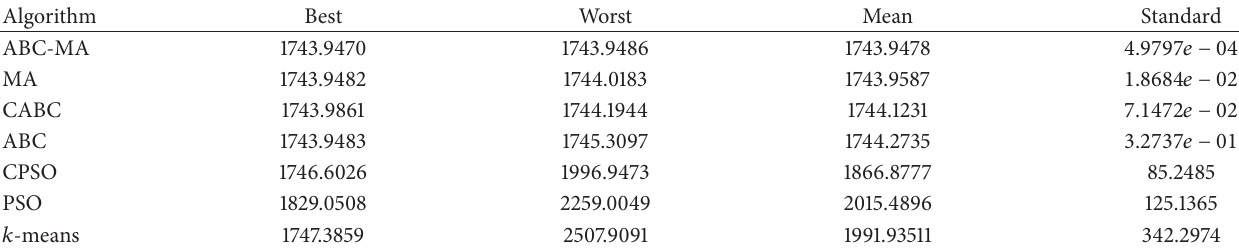
Table 1: Results obtained by the algorithms for 20 different runs on Art1 data.